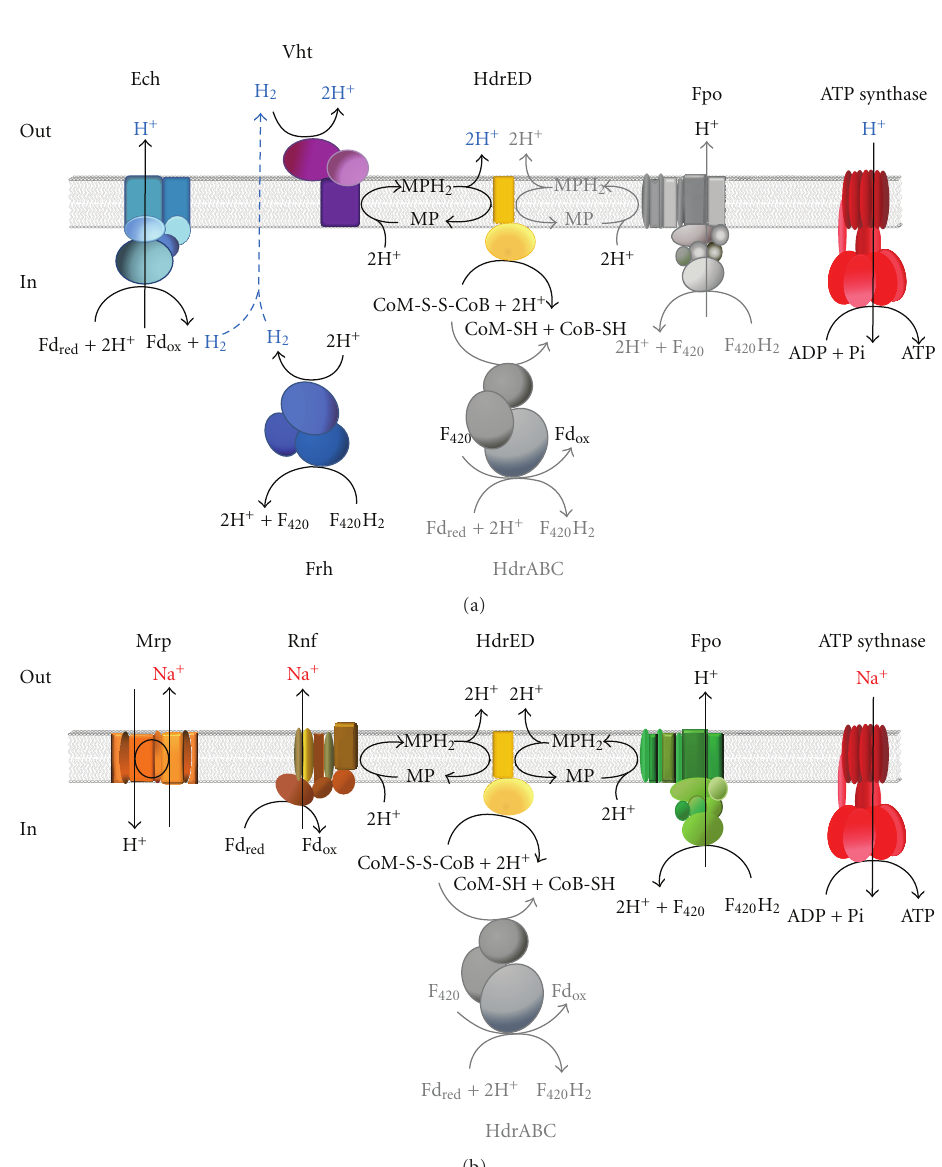
Figure 6: Comparison of proposed energy conserving electron-transfer routes in (a) freshwater-inhabiting and (b) saltwater-adapted members of the family Methanosarcinaceae . The proposed models of the energy metabolism are mainly based on the results of gene deletion and expression analyses in the species Msc. barkeri [54], Msc. mazei [55] and Msc. acetivorans [42, 56, 57]. The postulated coupling ion for ATP-synthesis is shown in blue (H + ) or red (Na + ). Enzyme complexes and reactions that are thought to bypass the main route of electron transfer are shown in grey. The shown electron bifurcation at the HdrABC complex is based on a proposal of Buan and Metcalf [58]. A membrane-bound sodium-translocating Mtr complex that could participate in the utilization of a chemiosmotic gradient was omitted from the figure for simplicity reasons. Abbreviations for electron transfer complexes and cofactors are explained in the text and Table